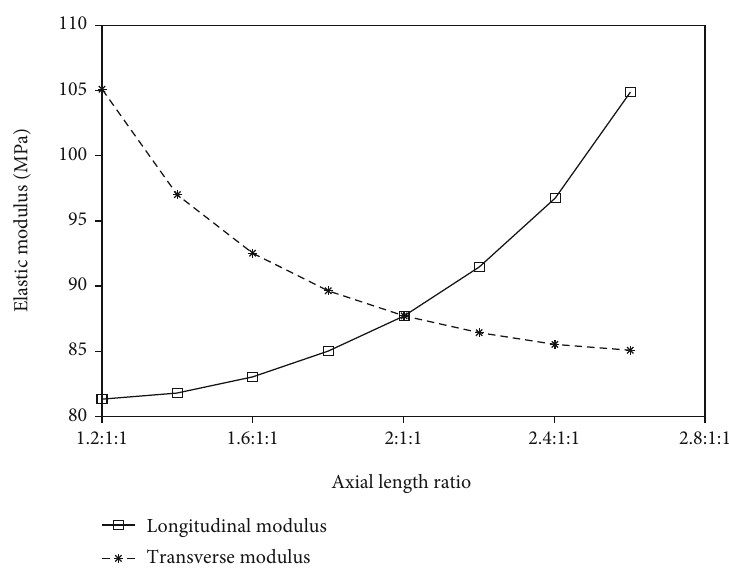
11 between the HFGMC and the FEM.